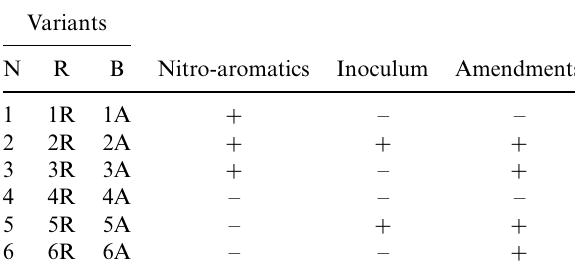
Table 1. Variants used in vegetation pot